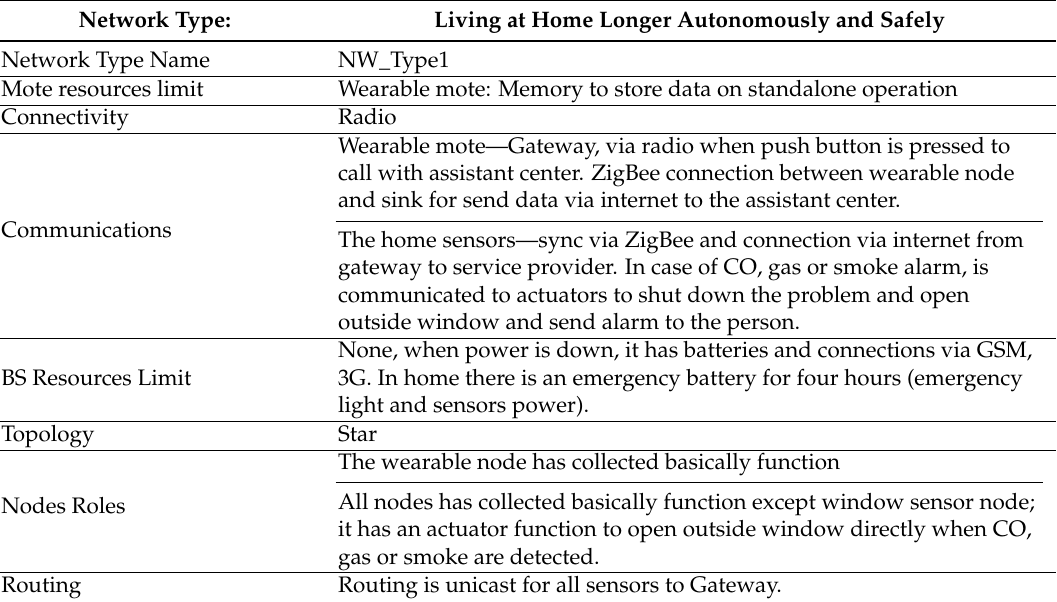
Table 4. Utility Matrix: Network type for the